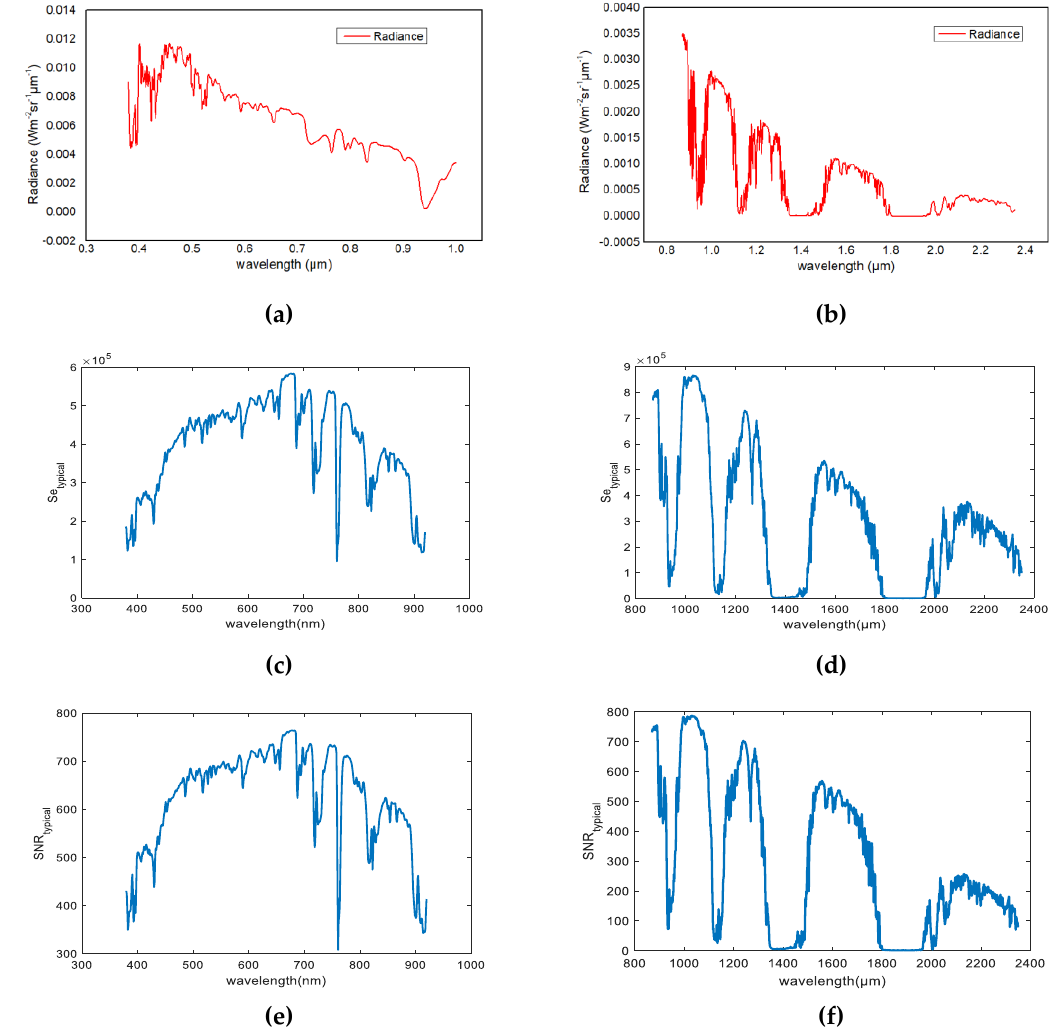
Figure 9. Signal-to-noise ratio (SNR) simulation results: ( a ) pupil radiance of Visible Near Infrared Radiance spectrometer (VNIR), ( b ) pupil radiance of the Short Wave Infrared Radiance spectrometer (SWIR), ( c ) signal electric number of VNIR, ( d ) signal electric number of SWIR, ( e ) VNIR spectrometer SNR, and ( f ) SWIR spectrometer SNR.